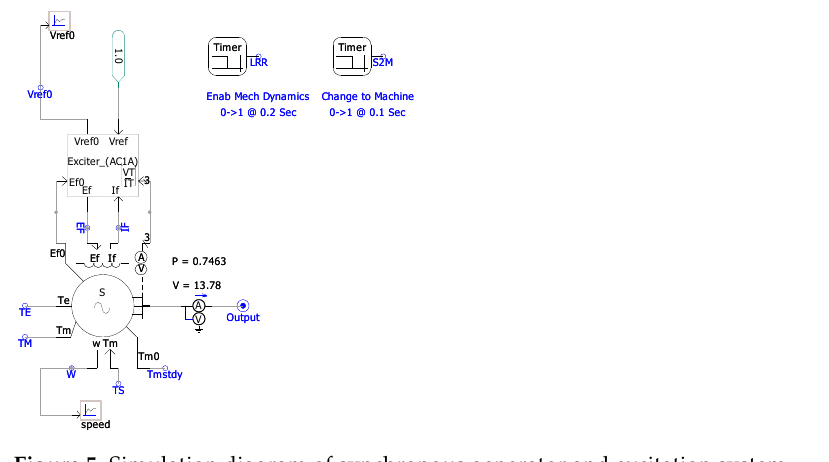
Figure 5. Simulation diagram of synchronous generator and excitation system.